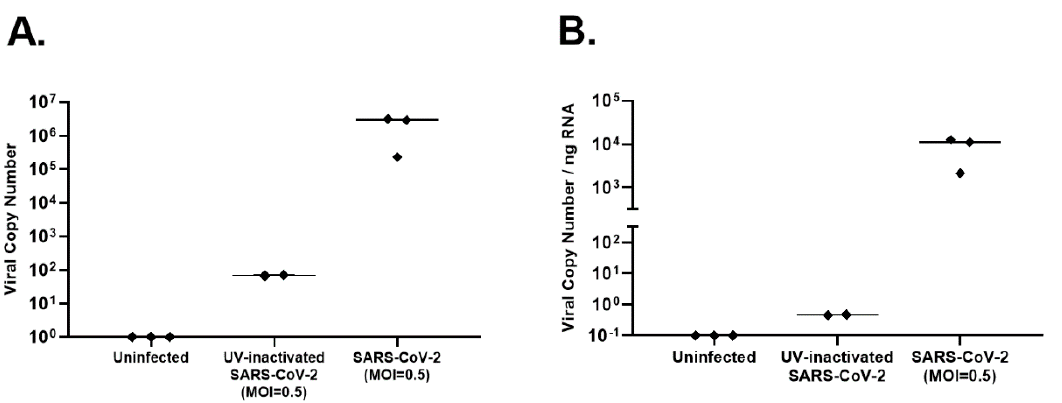
Figure 3. Viral replication in SARS-CoV-2-infected organotypic primary human airway epithelial cells (AEC). Viral copy number was measured by performing quantitative polymerase chain reaction (qPCR) using SARS-CoV-2 inactivated RNA isolated 96 h following inoculation of AECs with SARS-CoV-2 at a MOI of 0.5 or UV-inactivated SARS-CoV-2. Panel ( A ). presents unadjusted copy number and Panel ( B ). presents copy number adjusted for RNA concentration.